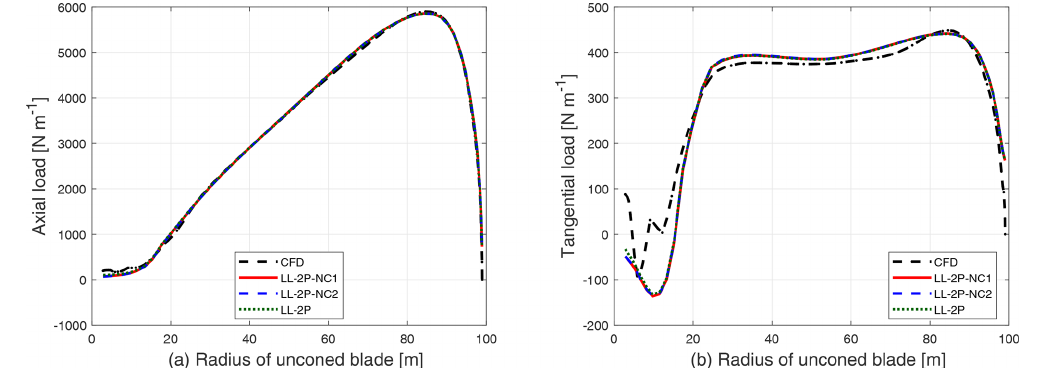
Figure 7. Comparison of axial load (a) and tangential load (b) of the upwind dihedral blade W-1 with additional 15 ◦ of upwind coning calculated from the fully resolved CFD and the two-point approach of the LL method without non-circulatory force (LL-2P), with non- circulatory lift (LL-2P-NC1), and with both non-circulatory lift and the non-circulatory pitch rate drag (LL-2P-NC2).